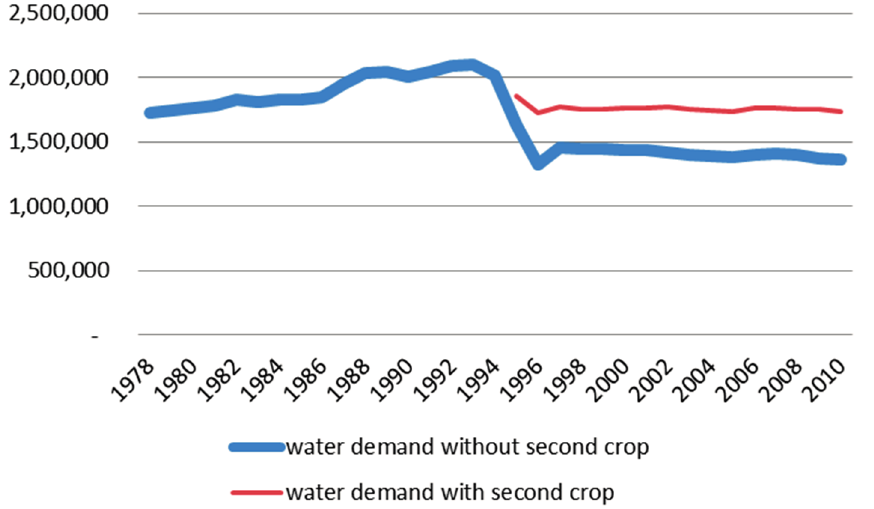
Figure 7. Irrigation norms and trends of water demand during summer season 1978 to 2010 (m 3